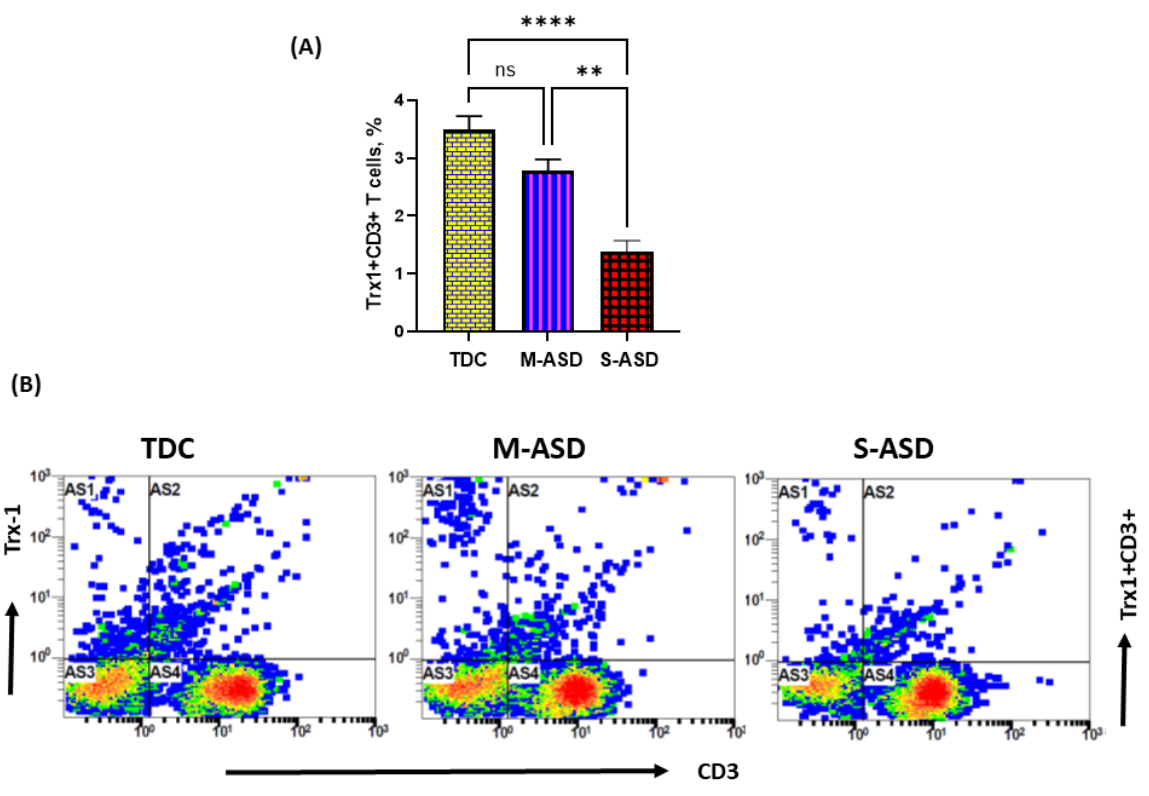
Figure 2. Trx1 expression in the T cells of the ASD and TDC groups. ( A ), Trx1+CD3+T cells, ( B ) Flow plot displaying the double-positive immunostaining of Trx1+CD3+T cells. PBMCs were segregated from whole blood, followed by flow cytometry. The ASD group was further divided into mild– moderate (M-ASD) and severe (S-ASD). Values are shown as the mean ± SEM, n = 22–25/group. ** p < 0.01; **** p <